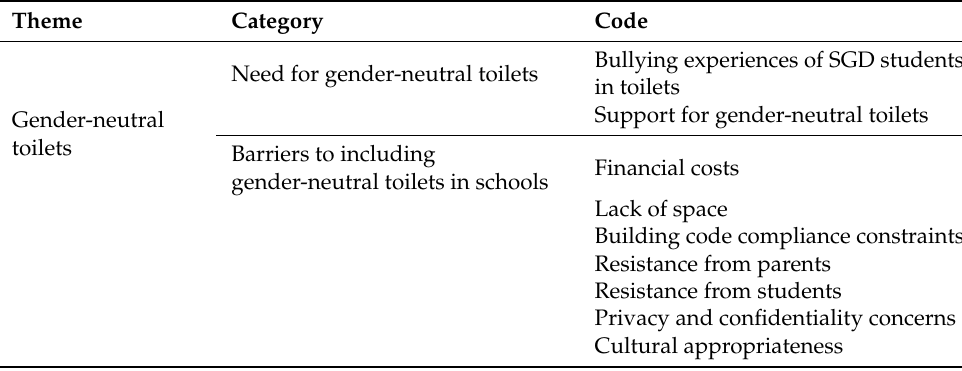
Table 2. Gender-neutral toilets: Theme, Categories and